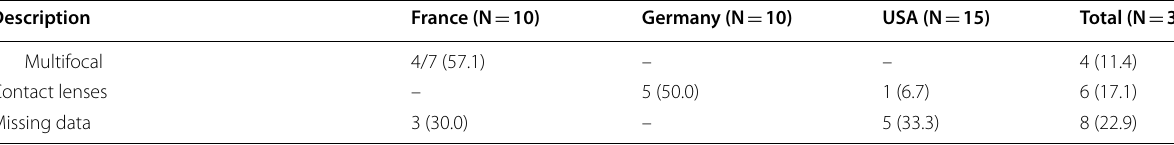
Stage 1: HCP interviews (round 1, n = 3) CD